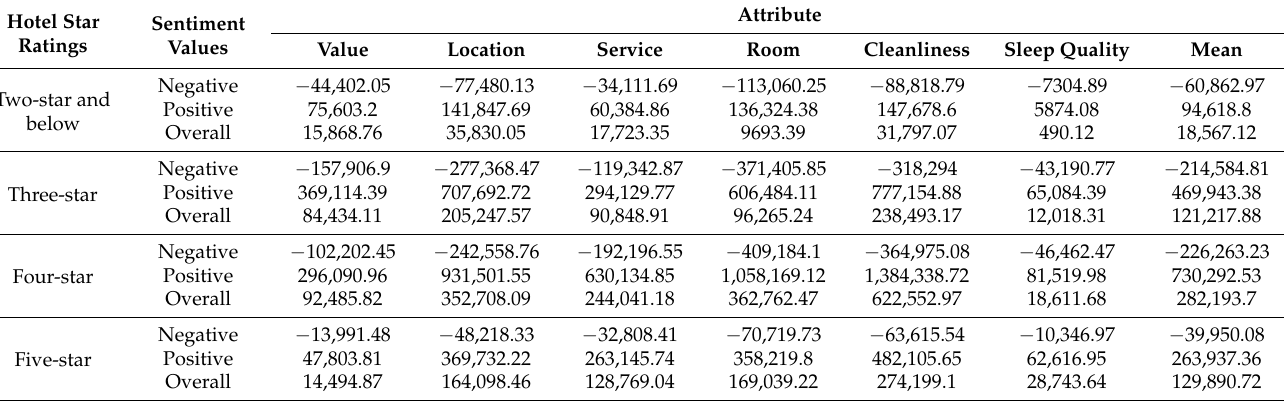
Table 9. The negative, positive and overall sentiment values of each attribute according to the hotel star